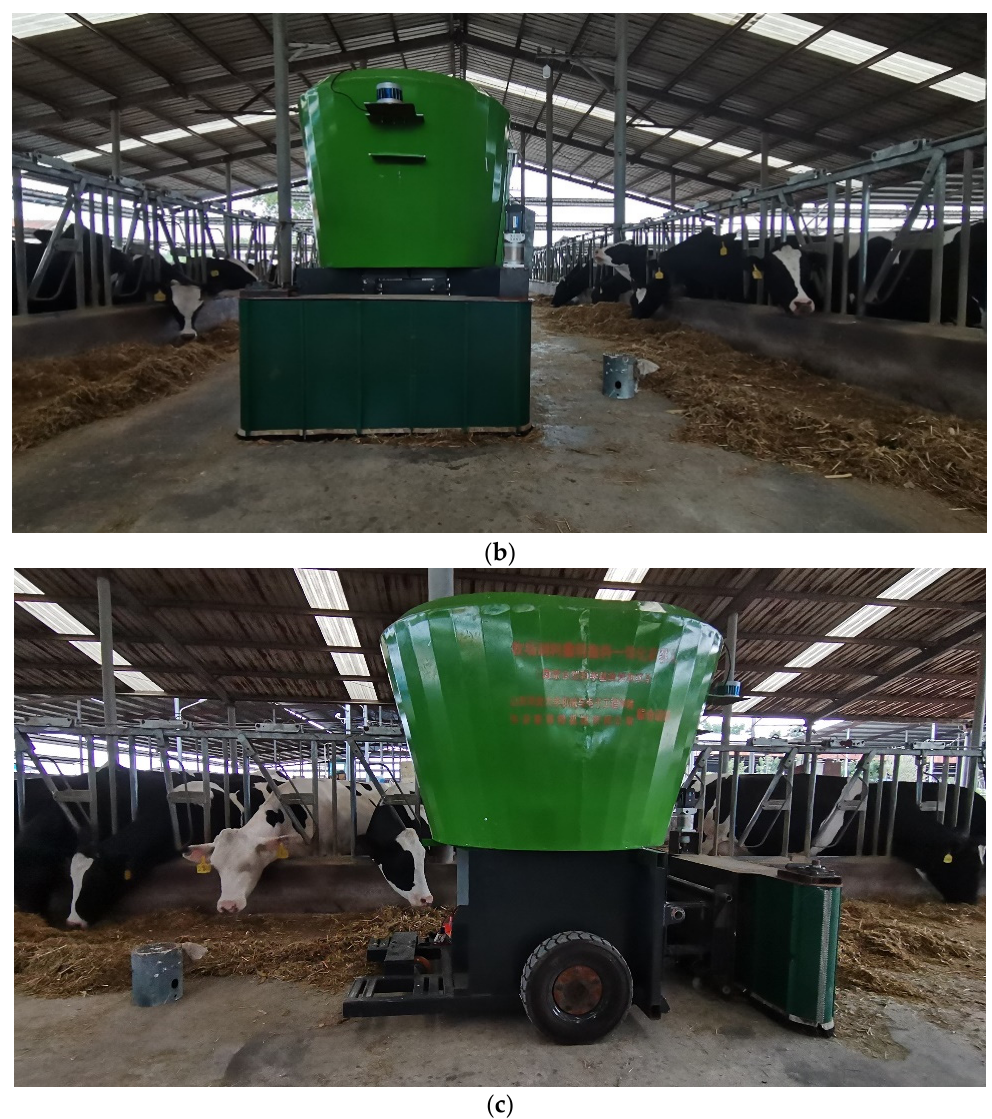
Figure 15. Obstacle avoidance scene and process: ( a ) Find the obstacle; ( b ) Get around obstacle; ( c ) Keep working.